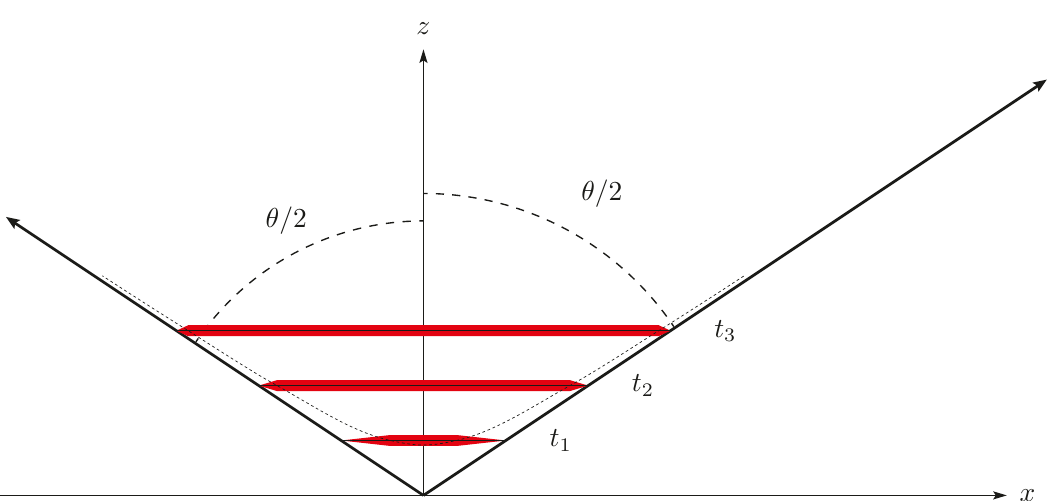
Figure 4 . The time-evolution of a string piece between two partons in an arbitrary Lorentz frame. The system is rotated so that the momenta (the magnitude of which are indicated by the lengths of the arrows) of the of the partons are in the x − z plane with equal but opposite angle w.r.t. the z -axis. The horizontal lines indicate the extension of the string horizontally and transversely at different times steps. The dotted curve indicates the hyperbola where in x the proper time of the string piece is equal to R S for a given z = t cos θ 2